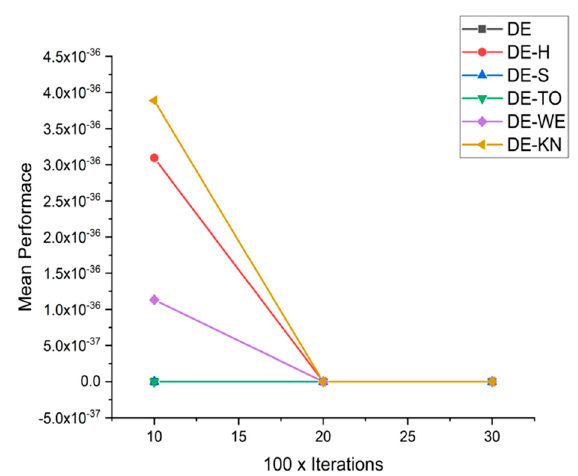
Figure 26. Convergence curve on fn4.